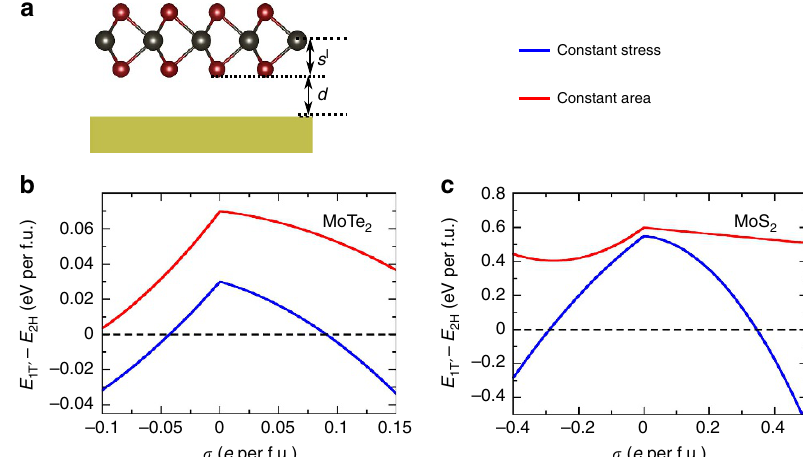
Figure 3 | Phase boundary at constant charge in monolayer MoTe 2 and MoS 2 . ( a ) Schematic representation of a monolayer TMDs separated by vacuum from an electron reservoir, for example, the surface of a metal. The internal energy difference between 2H and 1T 0 phases E 1T 0 (cid:2) E 2H changes with respect to the charge density s as shown in b and c . The units are per formula unit (f.u.). The blue line represents constant-stress (stress-free) case, in which both 2H and 1T 0 are structure relaxed. The red line represents the constant-area case, in which the monolayer is clamped to its 2H lattice constants. ( b ) Semiconducting 2H-MoTe 2 is a stable phase and semimetallic 1T 0 -MoTe 2 is metastable when the monolayer is charge neutral. However, 1T 0 -MoTe 2 is more thermodynamically favourable when the monolayer is charged beyond the positive or negative threshold values. The charge thresholds exhibit a significant dependence on the relaxation of lattice constants, indicating that the precise transition point may be sensitive to the presence of a substrate. ( c ) MoS 2 is stable in the 2H structure when charge neutral. The magnitude of charge required for the transition to 1T 0 is larger than for MoTe 2 . In both cases, transition at constant stress is more easily induced than the transition at constant